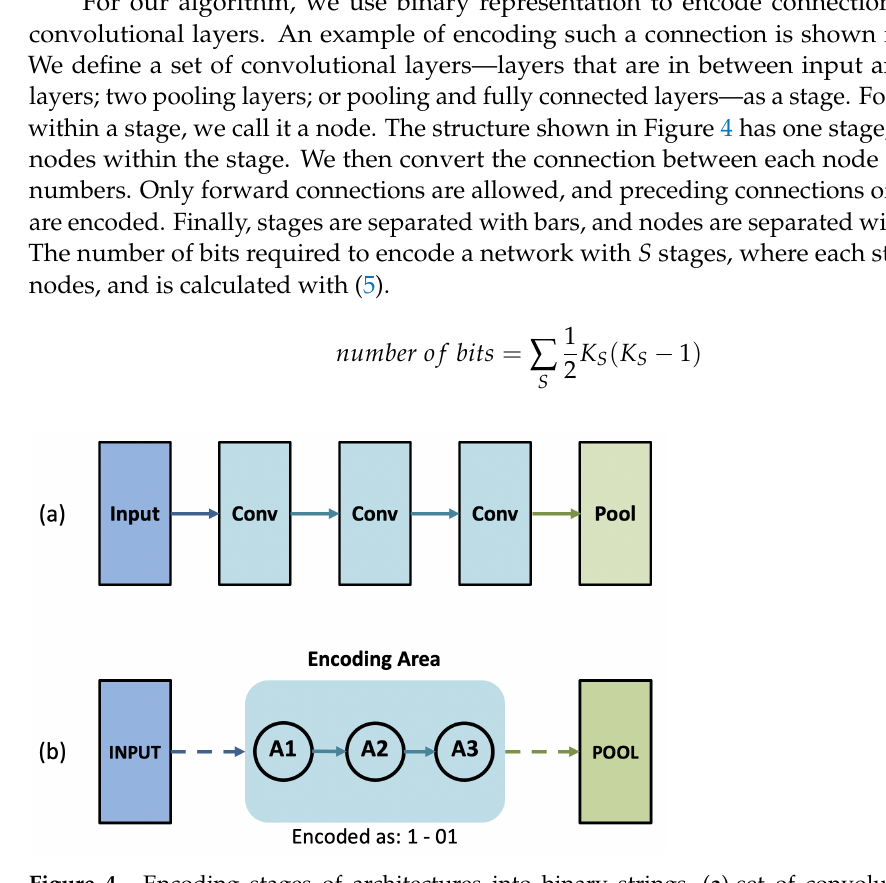
Figure 4. Encoding stages of architectures into binary strings. ( a )-set of convolutional layer; ( b )-encoded version of the layers in ( a ). In ( b ), numbers before and after the hyphen represent connections to node A 2 and A 3,